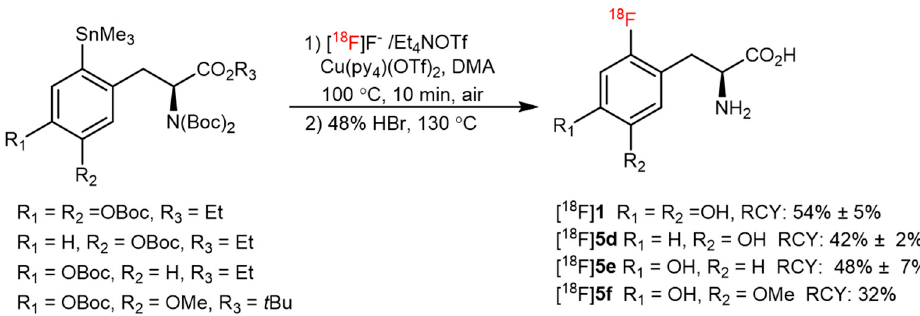
Figure 7. The preparation of [ 18 F] 1 and [ 18 F] 5d – 5f from a Cu-mediated 18 F-fluorination of arylstan- nanes. Modified from Zarrad et al. [43].